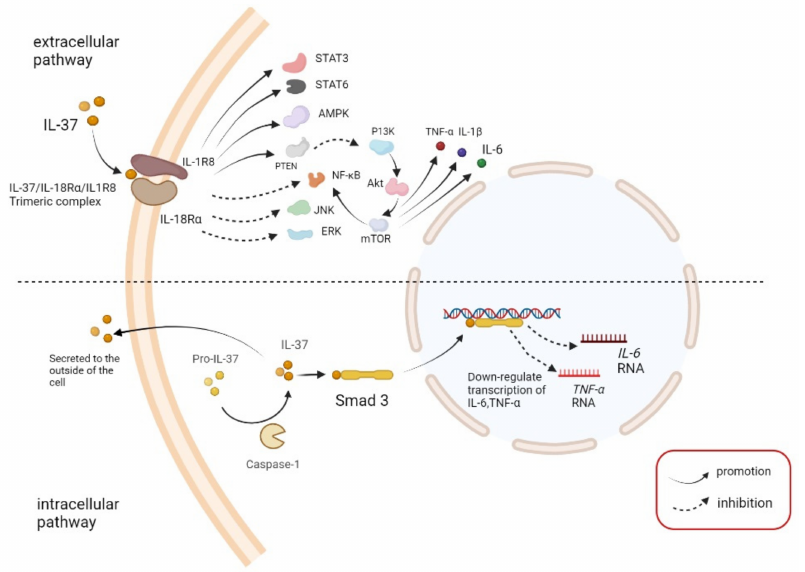
Figure 1. Pathway through which Interleukin-37 (IL-37) exerts anti-inflammatory effects. In extracel- lular pathway, IL-37 binds with IL-18 receptor α chain (IL-18R α ) and IL-1 receptor 8 (IL-1R8) to form a trimeric complex. The trimeric complex activates adenosine 5 (cid:48) -monophosphate-activated protein kinase (AMPK), signal transducer and activator of transcription 3 (STAT3), STAT6 and phosphate and tension homology deleted on chromosome ten (PTEN), and inhibits the pathway of c-Jun N-terminal kinase (JNK), extracellular regulated protein kinases (ERK) and nuclear factor- κ B (NF- κ B). At the same time, PTEN inhibits the PI3K/AKT/mTOR pathway, thereby inhibiting the production of NF- κ B and pro-inflammatory cytokines, including IL-6, tumor necrosis factor- α (TNF- α ) and IL-1 β . In intracellular pathway, pro-IL-37 is cleaved by caspase-1 to become IL-37. A part of IL-37 is released outside the cell, and a part binds to drosophila mothers against decapentaplegic 3 (Smad3) in the cytoplasm. After entering the nucleus, it inhibits the transcription of other inflammatory cytokines, such as IL-6 and TNF- α